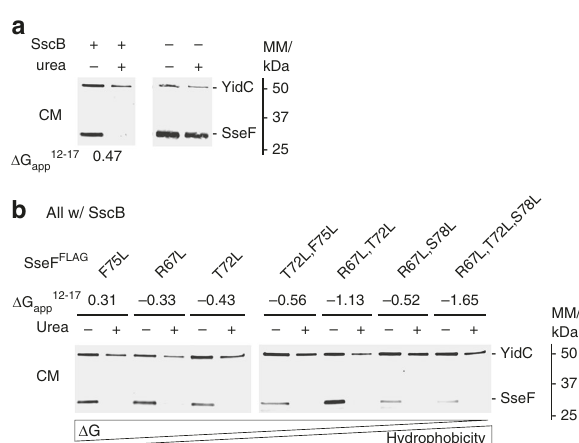
Fig. 4 Analysis of membrane integration of SseF in dependence of its chaperone SscB ( a ) Salmonella Δ sscB , Δ sseF , Δ sseG triple mutants were grown under SPI-2-inducing conditions and complemented with SseF FLAG with or without the chaperone SscB from a rhamnose-inducible low-copy number plasmid. Crude membranes were prepared and treated with 8 M urea for 1 h at room temperature as indicated. SseF content was then analyzed by SDS PAGE, Western blotting and immunodetection with anti- FLAG and anti-YidC (inner membrane control) antibodies. b As in a but showing expression of indicated SseF FLAG mutants with increased hydrophobicity of the fi rst TMS. A representative result of three independent experiments is shown. Abbreviation: CM: crude